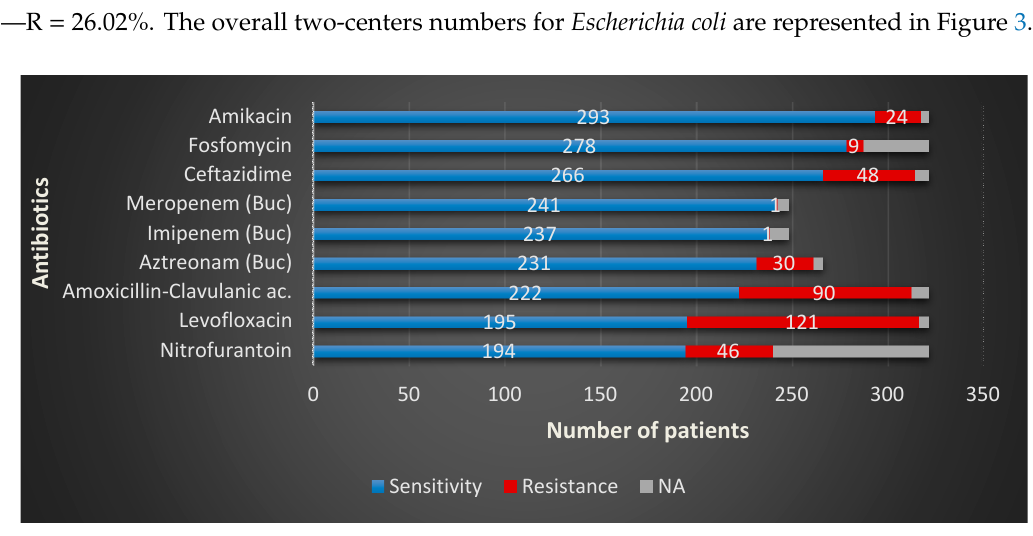
Figure 3. Escherichia Coli overall sensitivity and resistance profiles in the study group.